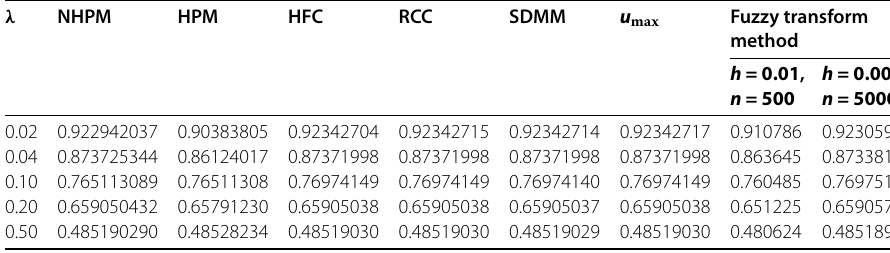
Table 1 A comparison for β = 1 of the FTM and approximate methods